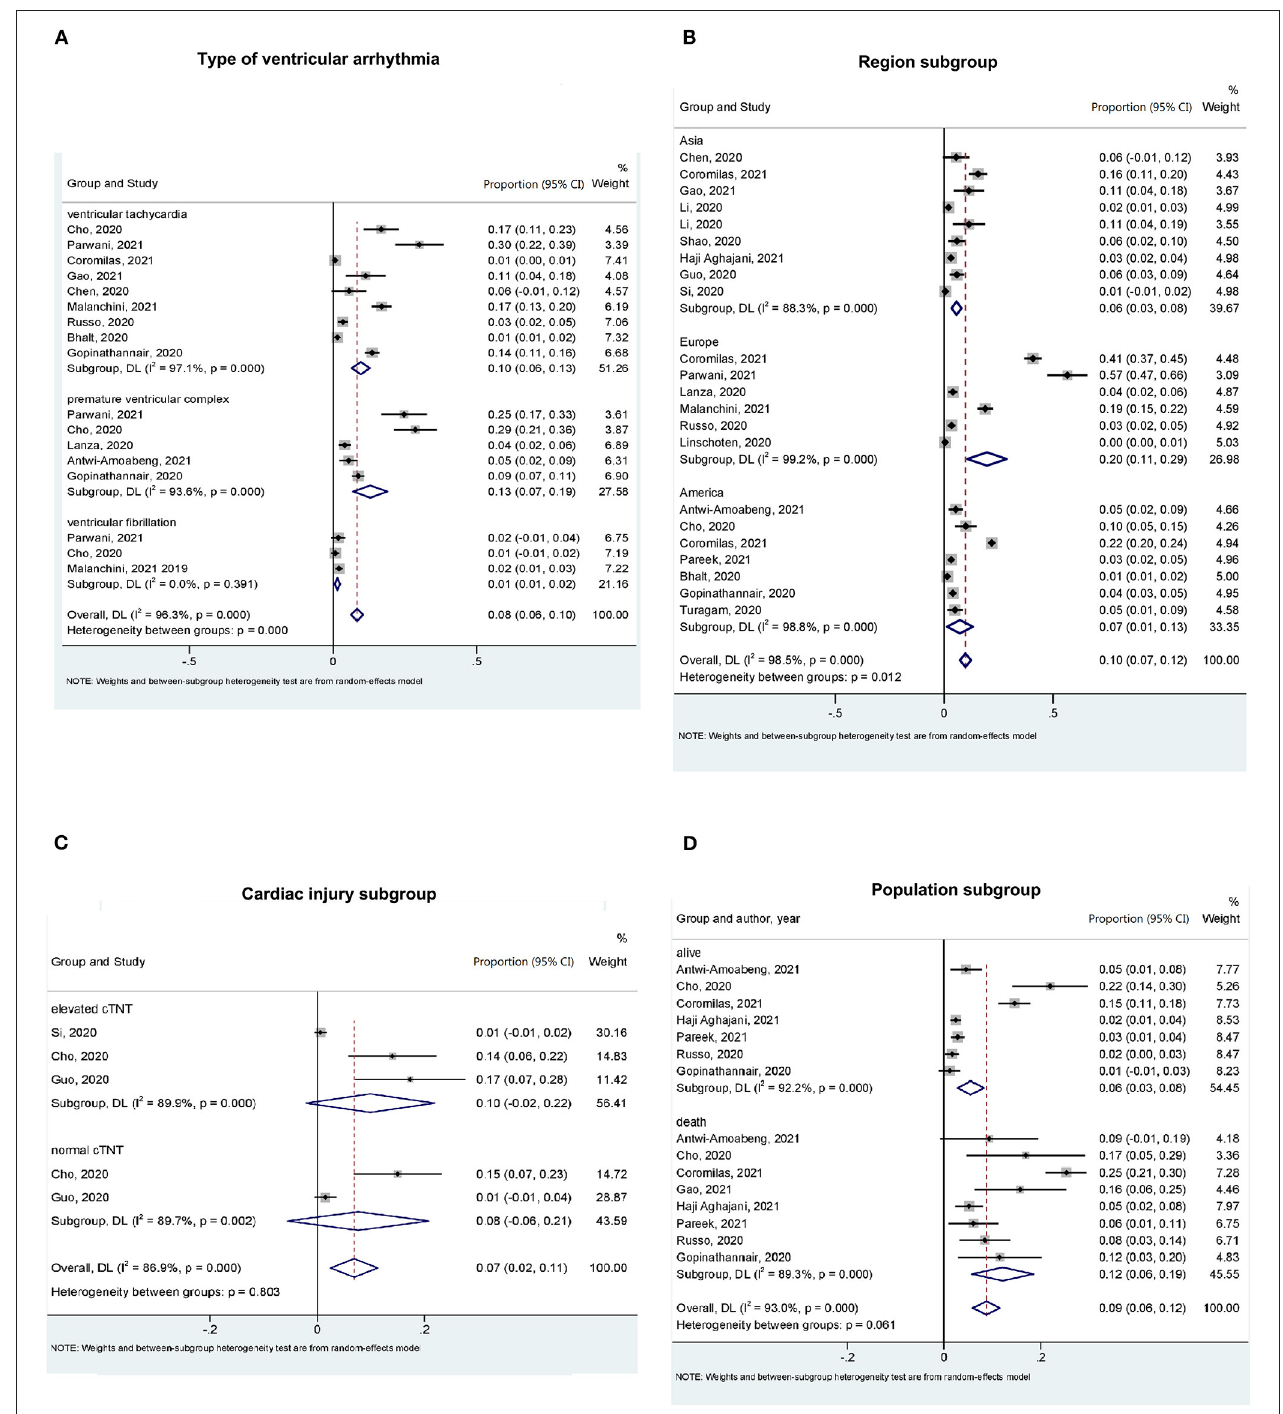
FIGURE 3 | Subgroup analysis for the prevalence of ventricular arrhythmia in patients with COVID-19. (A) Ventricular arrhythmia type subgroup. According to ventricular arrhythmia type, ventricular tachycardia, premature ventricular complex, and ventricular fibrillation group were divided. (B) Region subgroup. According to region, Asia, Europe, and the United States group were divided. (C) Cardiac injury (cardiac troponin T level) subgroup. All the researches were divided into elevated cTNT and normal cTNT group according to cTNT level. (D) Population (alive and dead) subgroup. Alive and death population were divided.